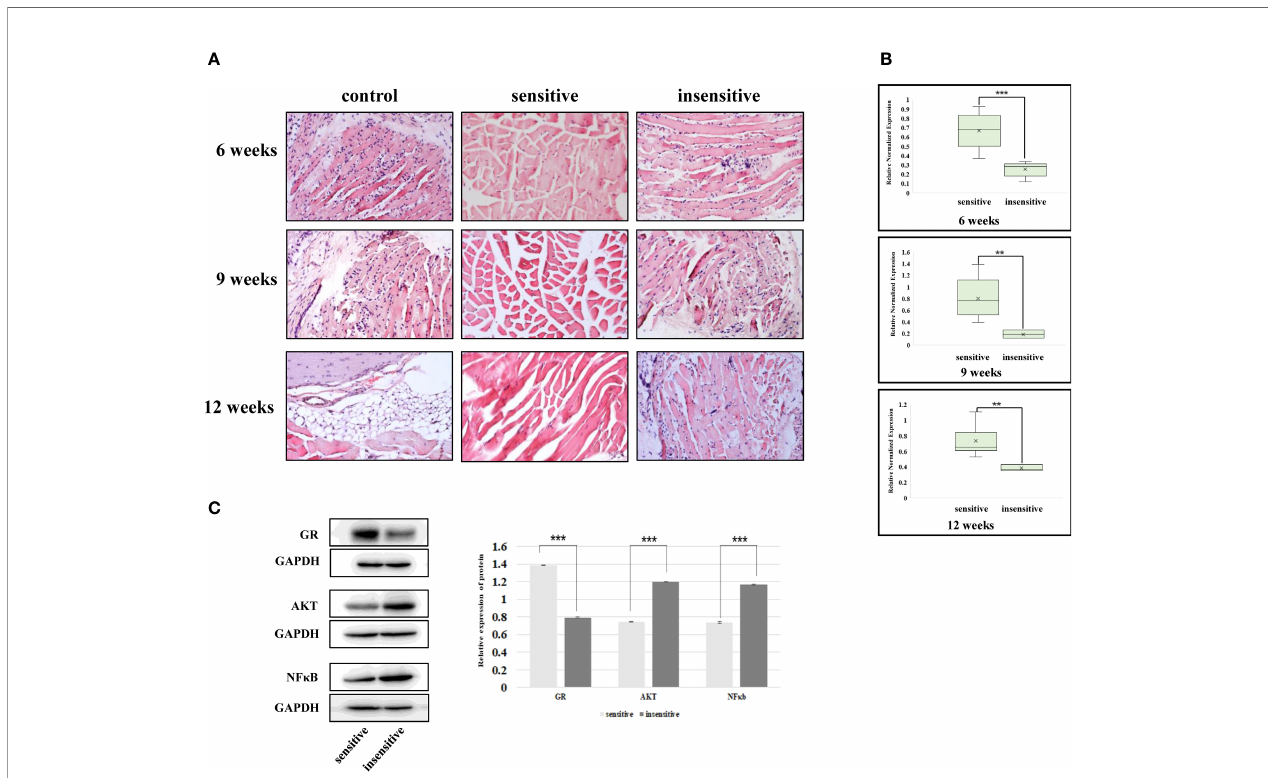
FIGURE 7 | The relationship between exosomes ’ mir-885-3p sequence, AKT/NF k B, and glucocorticoid sensitivity exists in vivo . (A) HE staining results of GO mice in the 6th, 9th, and 12th weeks of treatment. (B) The level of mir-885-3p sequence in plasma exosomes of mice in the 6th, 9th, and 12th weeks of treatment; ** p < 0.01; *** p < 0.001. (C) Western blot detection of GR, AKT, and NF k B protein levels; *** p <